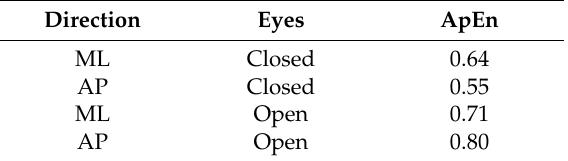
Table 1. Approximate entropy (ApEn) values for quiet standing with and without visual feedback. Direction